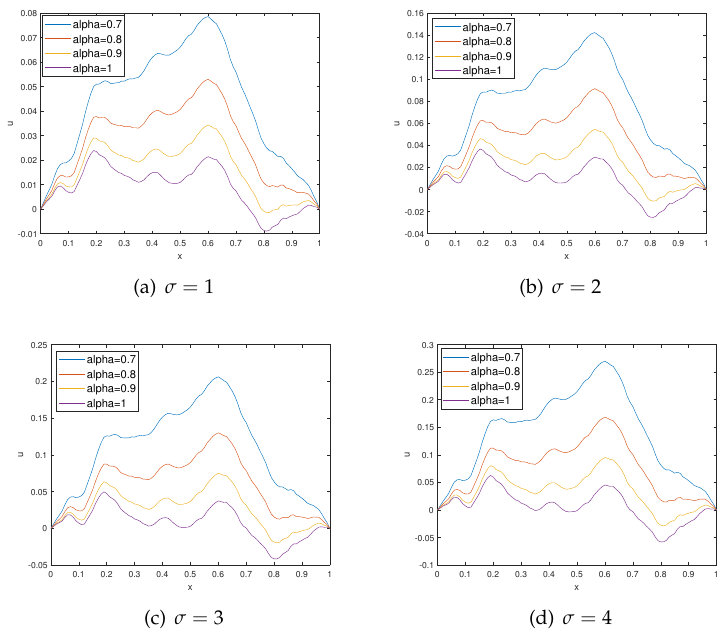
Figure 10. The approximation solutions of Example 2 (case (1)) with t = 0.3.